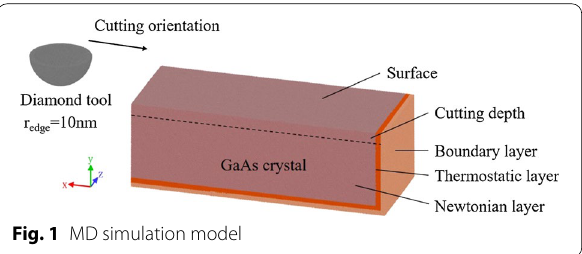
Fig. 1 MD simulation model